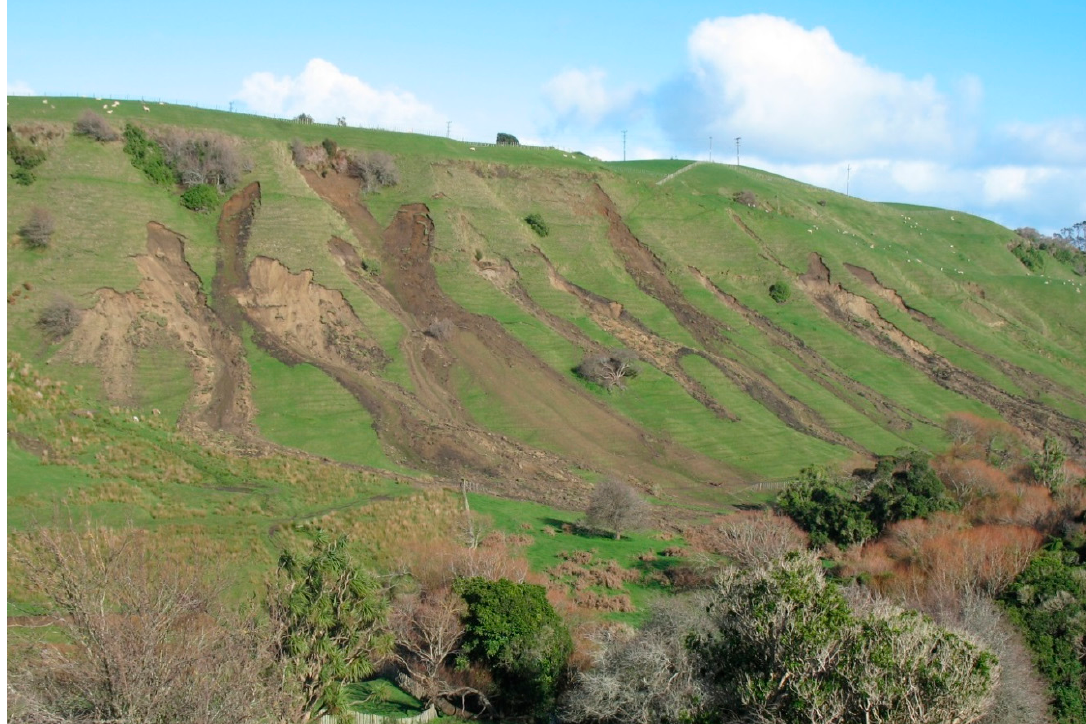
Figure 2. Landslides caused by a heavy rainstorm in June 2015 (Photo © Harley Betts).